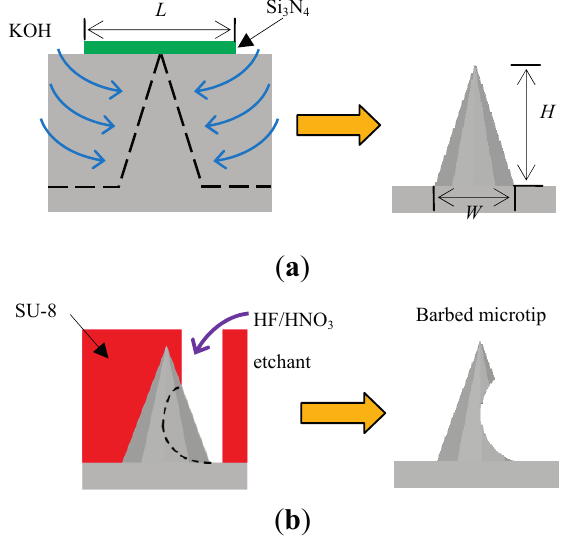
Figure 1. Schematics of a microtip after ( a ) anisotropic and ( b ) isotropic wet